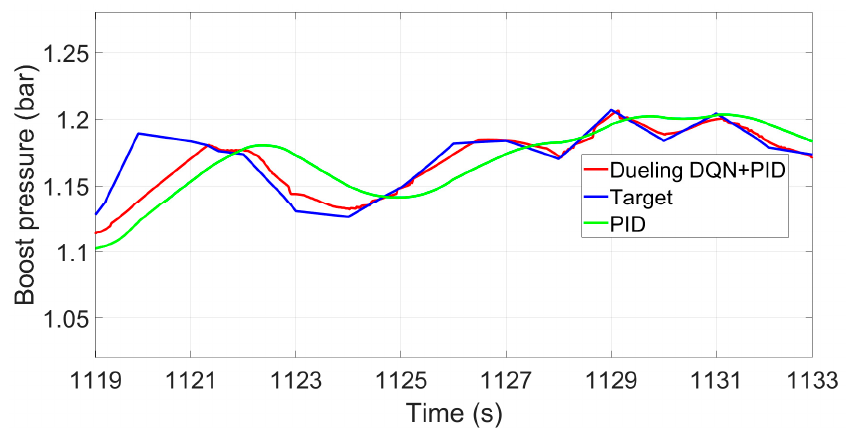
Figure 13. Control behavior after a continuous learning using a long driving cycle containing this specific driving cycle.